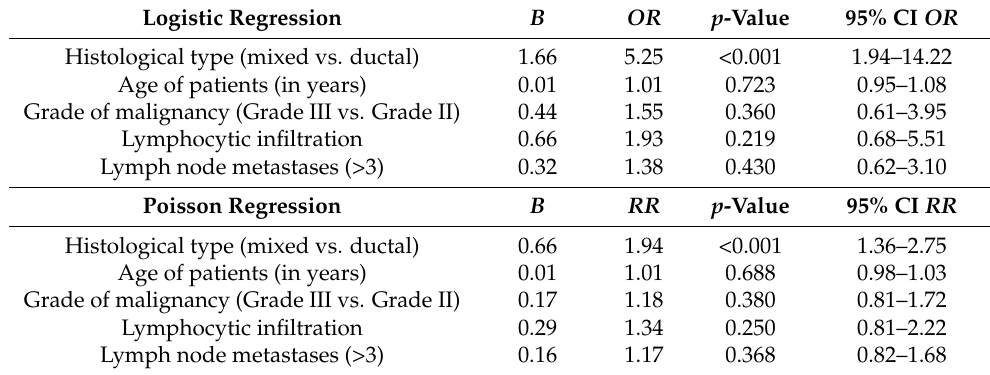
Table 4. Multiple logistic and Poisson regression models with five-year mortality as the outcome variable. Logistic Regression B OR p -Value 95% CI OR Histological type (mixed vs. ductal) 1.66 5.25 <0.001 1.94–14.22 Age of patients (in years) 0.01 1.01 0.723 0.95–1.08 Grade of malignancy (Grade III vs. Grade II) 0.44 1.55 0.360 0.61–3.95 Lymphocytic infiltration 0.66 Poisson Regression B RR p -Value 95% CI RR Histological type (mixed vs. ductal) 0.66 1.94 <0.001 Age of patients (in years) 0.01